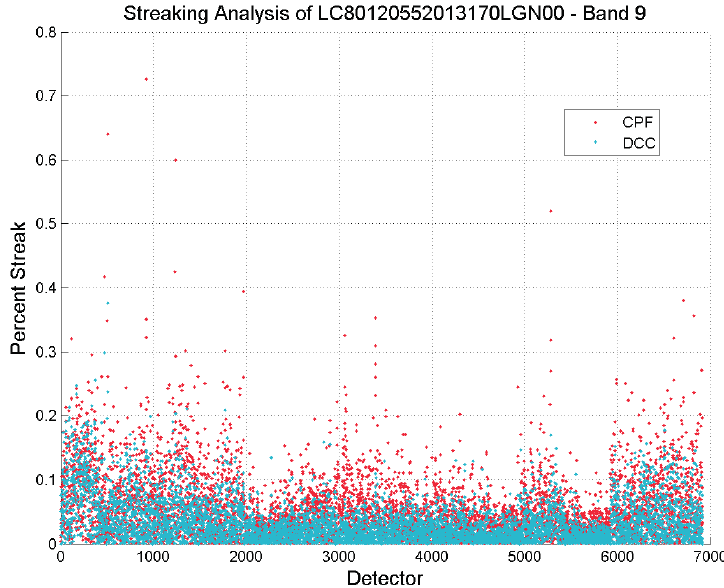
Figure 8. Streaking analysis of the DCC test image shown in Figure